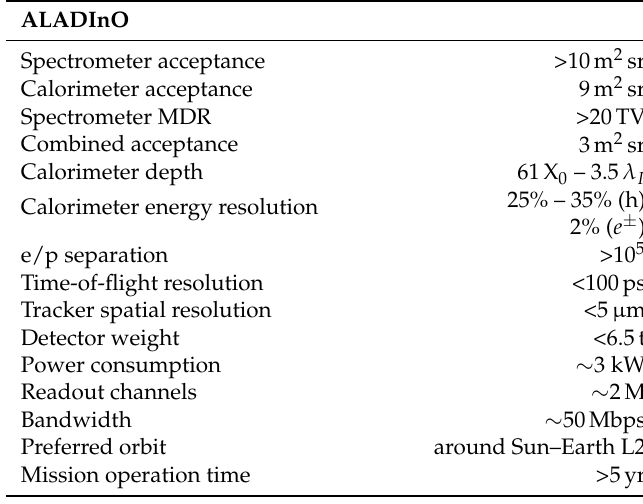
Table 1. Main detector figures of merit for the baseline ALADInO mission. Values of acceptances refer to particles in the fiducial volume of the